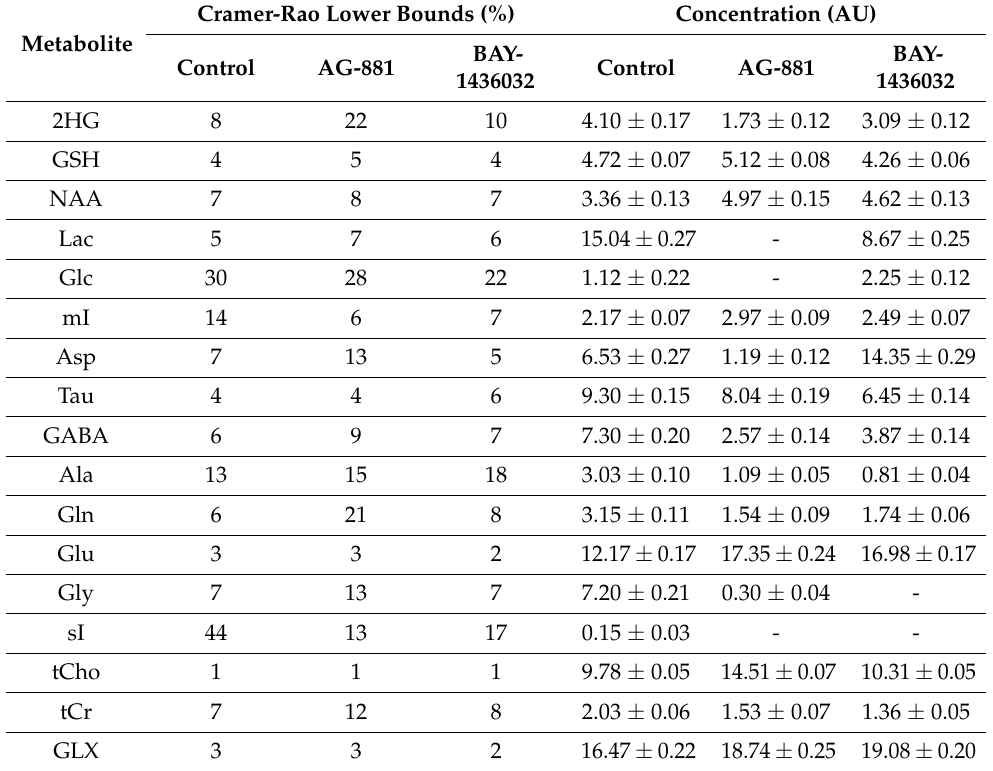
Table 1. Metabolite levels significantly different between control and treated U87IDHmut tumors at D5 ±